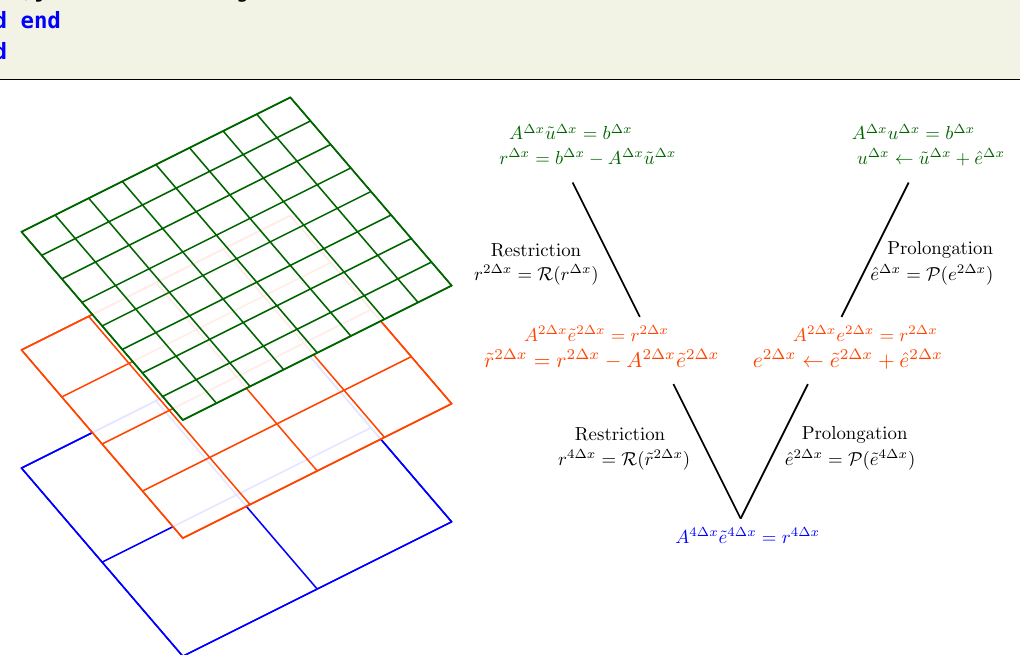
Figure 22. Illustration of multigrid V-cycle framework with three levels between fine and coarse grid. For full multigrid cycle, the coarsest mesh has 2